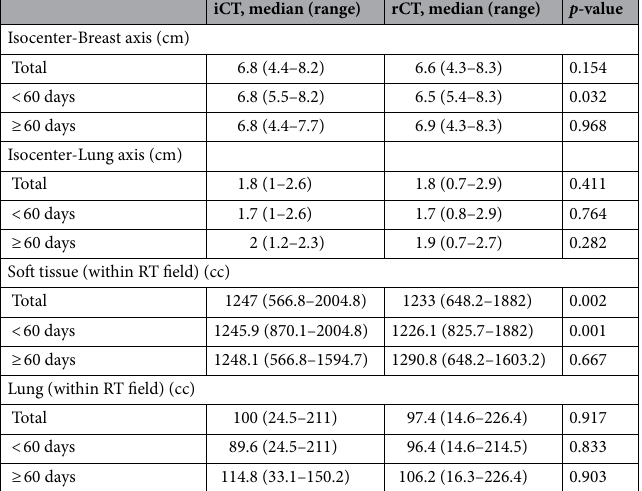
Parameters p -value iCT Isocenter-Breast axis (cm) vs Lung (within RT field) (cc) 0.654 Isocenter-Lung axis (cm) vs Lung (within RT field) (cc) < 0.001 Isocenter-Breast axis (cm) vs Soft tissue (within RT field) (cc) < 0.001